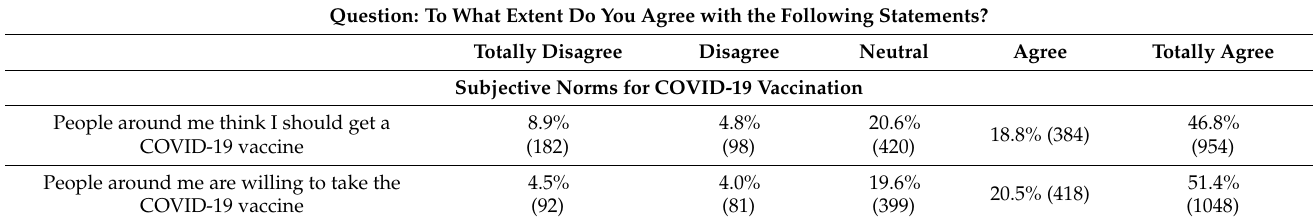
Table 5. Participants’ subjective norms ( n = 2038).